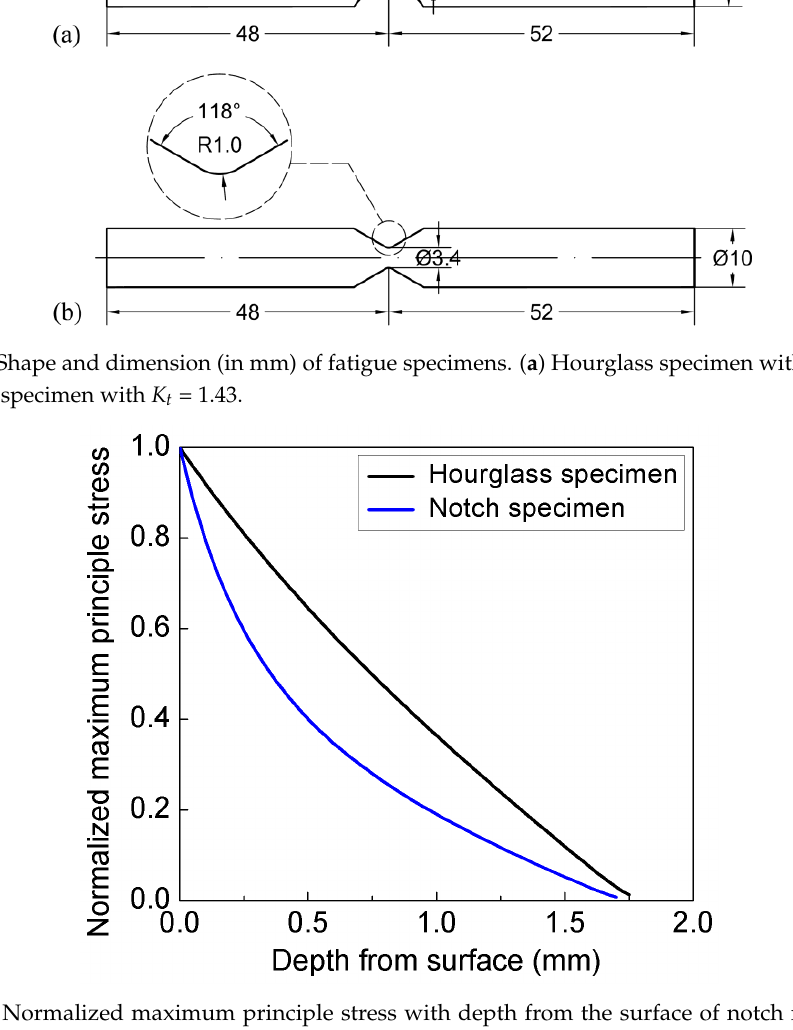
Figure 2. Normalized maximum principle stress with depth from the surface of notch root or the smallest cross section of the specimen.